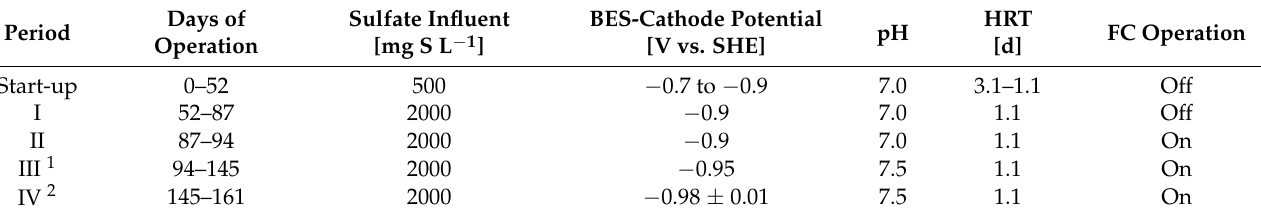
Table 1. Operational conditions in each experimental